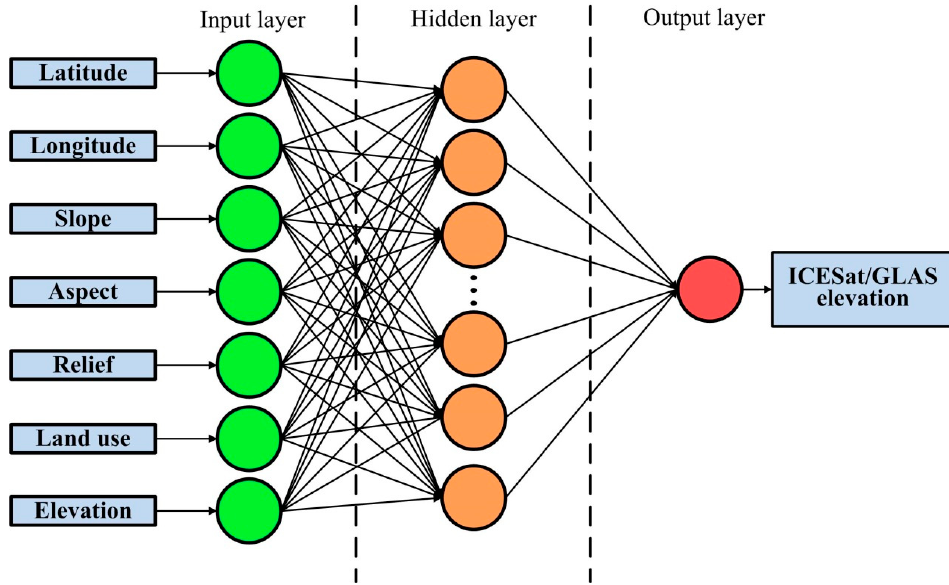
Figure 3. Structure of back propagation neural network (BPNN) for 3-arc-second SRTM (SRTM3) DEM correction.